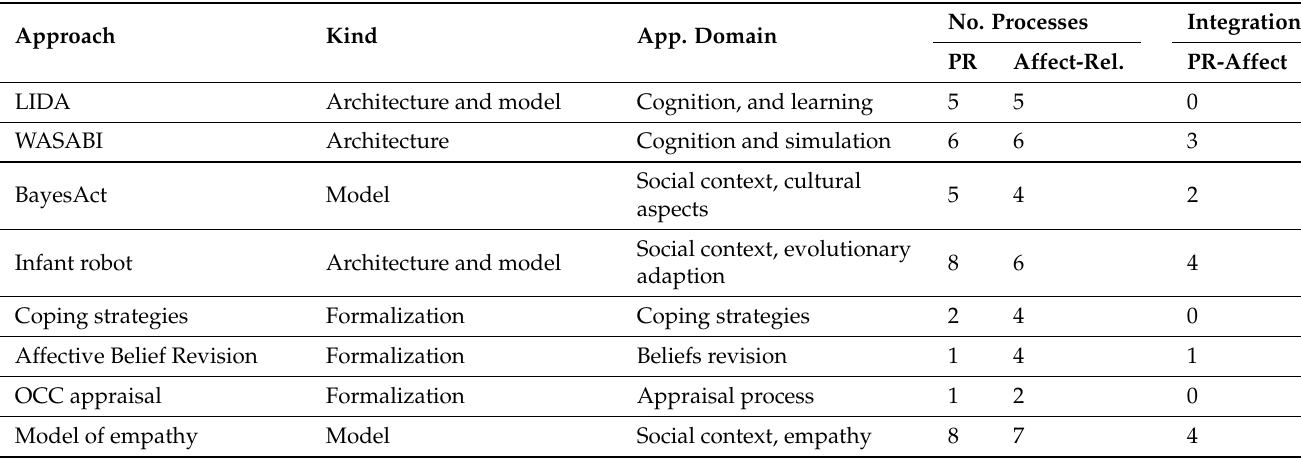
Table 2. Summary of characteristics of the computational approaches. App. Domain: application domain, PR: practical reasoning, Affect-rel.: affect related.